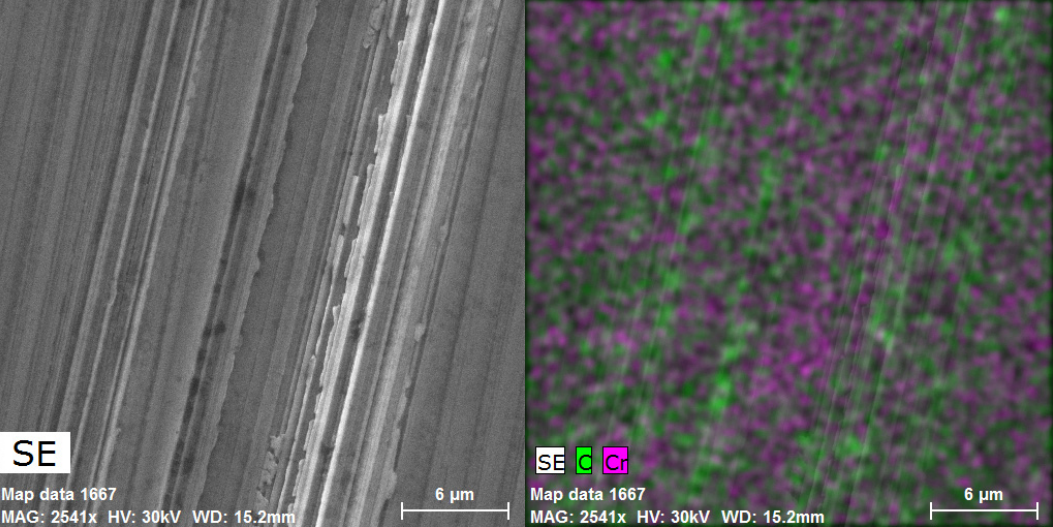
Figure 1. SEM image of as-cut samples of S1 surface ( left ) with carbon and chromium mapping ( right ).